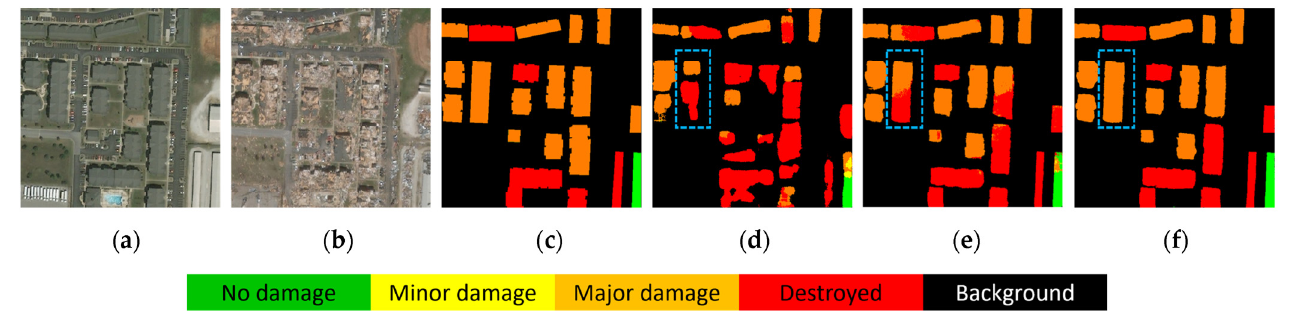
Figure 1. Illustration of building damage assessment results based on semantic segmentation. ( a ) Pre-disaster image, ( b ) post-disaster image, ( c ) ground truth, ( d ) results based on post-disaster image, ( e ) results based on bi-temporal images, and ( f ) results based on bi-temporal images and object-based post-processing.